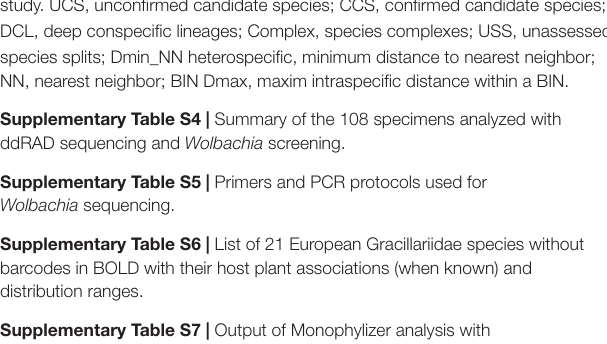
Supplementary Table S8 | Summary of intraspecific and interspecific distances calculated with PyCOIStats v1.3. Supplementary Table S9 | Geographic distribution of 39 species with multiple BINs. Supplementary Table S10 | Host use of 25 species with multiple BINs. Supplementary Table S11 | Nine species with different BINs co-occurring sympatrically (in same locality or localities a short distance apart) and sharing the same host plant. Supplementary Table S12 | List of 15 European Gracillariidae species without host plant data. Supplementary Figure S1 | Biogeographic classification of 284 European species (including 263 barcoded and 21 not barcoded). On the vertical axis, the total number of gracillariid species in each biogeographic category is given between parentheses. In the legend, the total number of gracillariid species in each subfamily is given between parentheses. Supplementary Figure S2 | Number of Gracillariidae species on different host plant families according to the biogeographic categories. Note: the plant families where overall less than five gracillariid species are known are grouped into the category “Other 20 plant families” including: Adoxaceae, Anacardiaceae, Asteraceae, Berberidaceae, Boraginaceae, Cannabaceae, Caprifoliaceae, Cistaceae, Ericaceae, Hypericaceae, Juglandaceae, Lauraceae, Malvaceae, Oleaceae, Plantaginaceae, Polygonaceae, Rhamnaceae, Rutaceae, Ulmaceae, and Vitaceae. Supplementary Figure S3 | Host plant use of European Gracillariidae fauna (284 species). Number of Gracillariidae species recorded per host plant family given between parentheses. In the legend, the total number of Gracillariidae species in each subfamily for which we have host plant data is given between parentheses. Supplementary Figure S4 | A neighbor-joining tree based on 6,791 DNA barcodes of 263 European Gracillariidae species belonging to 312